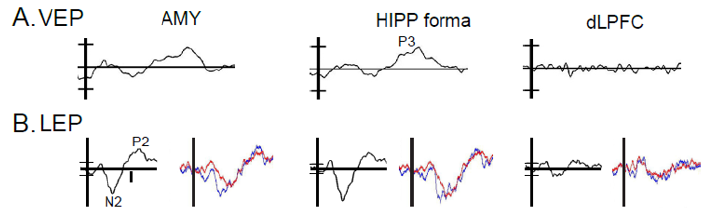
Figure 3. Activations (ERP see Abbreviations) during visual and nociceptive stages for AMY, HIPP, and dlPFC (dorsolateral prefrontal cortex). ( A ) Visual Evoked Responses (VER) where Baseline +/ − 3SD is indicated by short horizontal bars on the vertical axis. P3 corresponds to P300 here and is related to the novelty of infrequent stimuli. Horizontal axes ( A , B ) − 30 to 600 ms. Vertical bar 10 µV, 5 µV in ( A ). ( B ) LEPs shown in black traces. Red and blue traces (right) demonstrate LEPs averaged from separate series of the stimuli included in the black trace and show reproducibility. Vertical bar 10 µV, 5 µV in A.